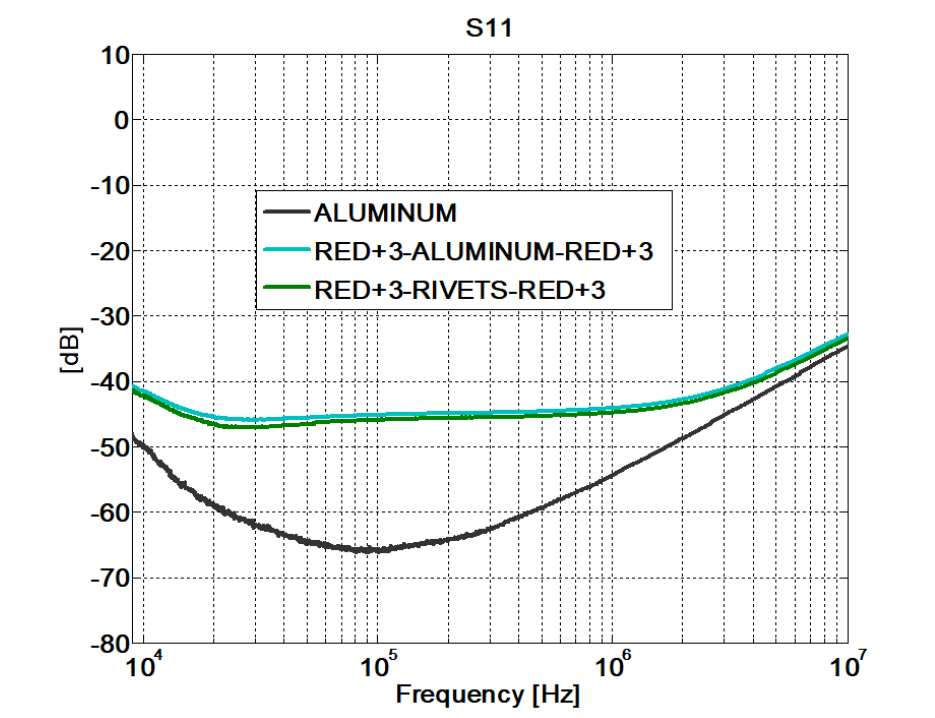
Figure 12. Scattering parameters test: S 11 . Fastener joints.